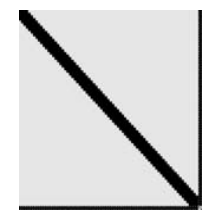
Figure 2. Structure of the normal matrix (black: filled, grey: not filled). It shows a band with values arising from the splines coefficients and stronger fill-in in the last rows and columns by the plane parameters.